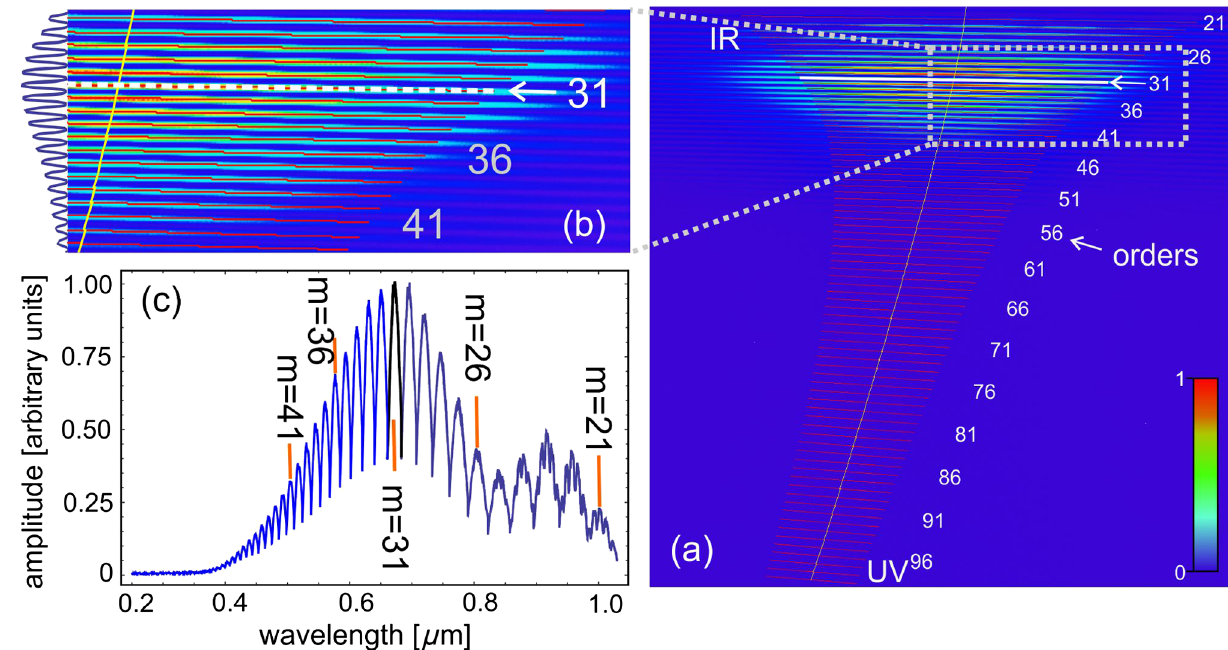
FIG. 8. Sample measurement of the UV-VIS spectrum using a QTH lamp. (a) illustrates the full image acquired with the 2D detector of the echelle spectrometer. The horizontal red lines indicate the (numbered) diffraction orders. The orange line connects the central wavelength λ 0 m of each order. (b) shows a zoomed part of (a) including a vertical line out showing the separation of the diffraction orders. The vertical extension of individual orders covers around 10 pixels. (c) presents a complete spectrum sampled from all orders as detailed in Sec. II D and III A